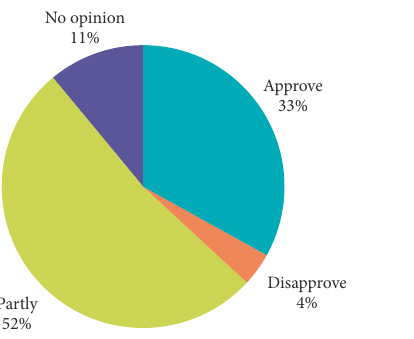
Figure 1. The results of question “What is your oppinion to changing foreign words by their Lithuanian equivalents?”